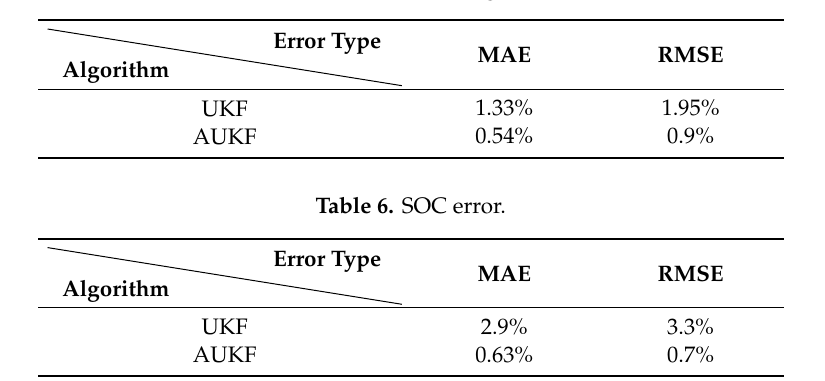
Table 5. Terminal voltage error.